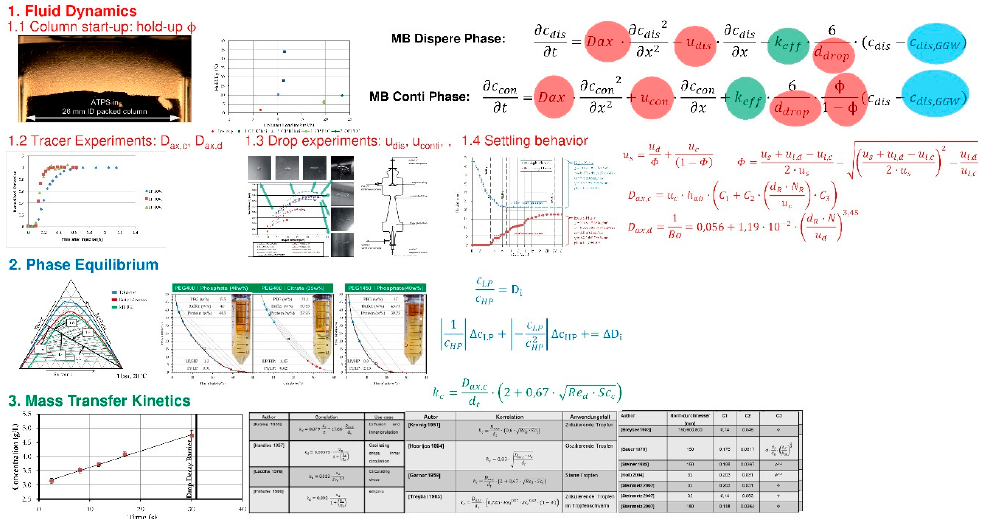
Figure 6 Figure 6. Liquid–Liquid (ATP) Extraction—process modeling workflow, recipe,